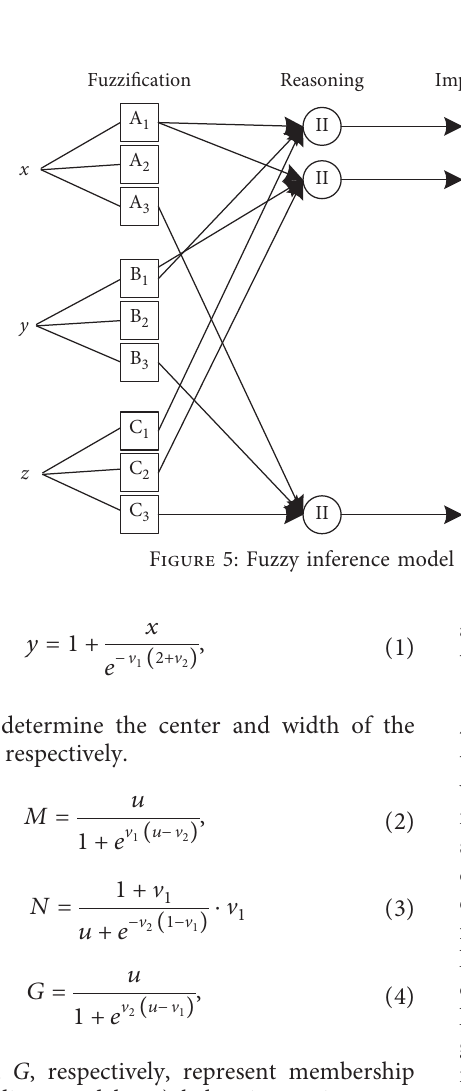
Figure 4: Application flowchart of social security fund cloud audit platform.